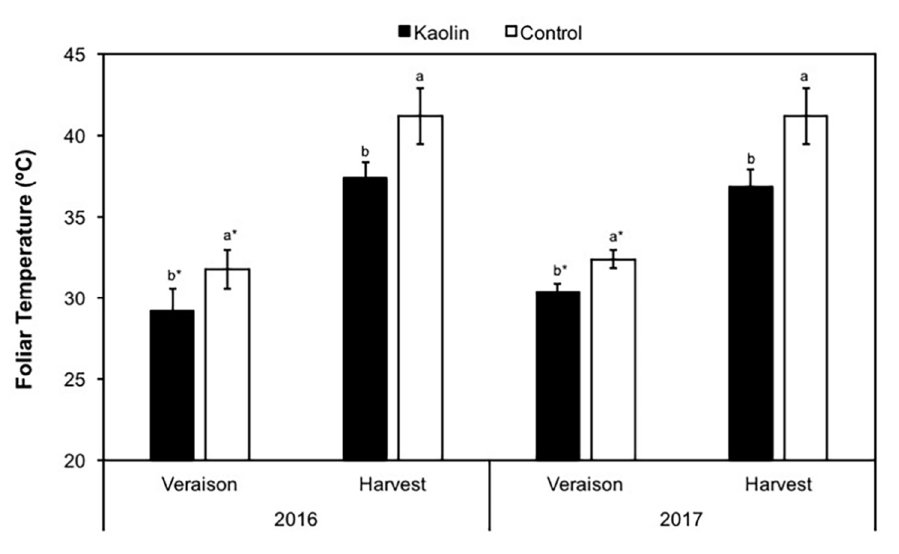
Figure 2. Leaf temperature of control and kaolin treated leaves in veraison and maturation in the midday period in 2016 and 2017. Values are presented as mean ± SD ( n = 24 per treatment). Different lowercase letters represent significant differences between treatments (control vs. kaolin), in the same stage of the season, and * represents significant differences between stages within the same treatment ( p < 0.05). Absence of superscript indicates no significant differences.